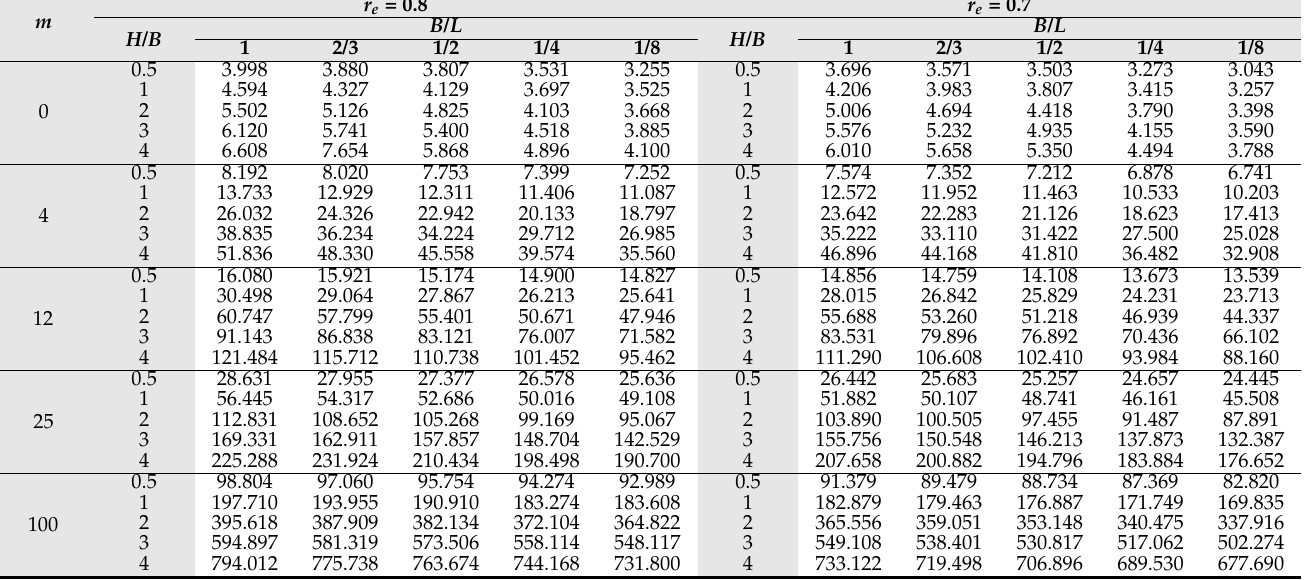
Table 2. Stability numbers, N ( r e = 0.8 and